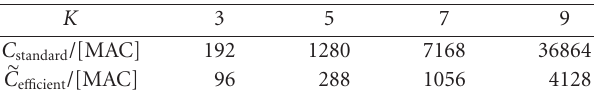
Table 1: GFSK high-performance receiver complexity with L = 3 and N = 2.